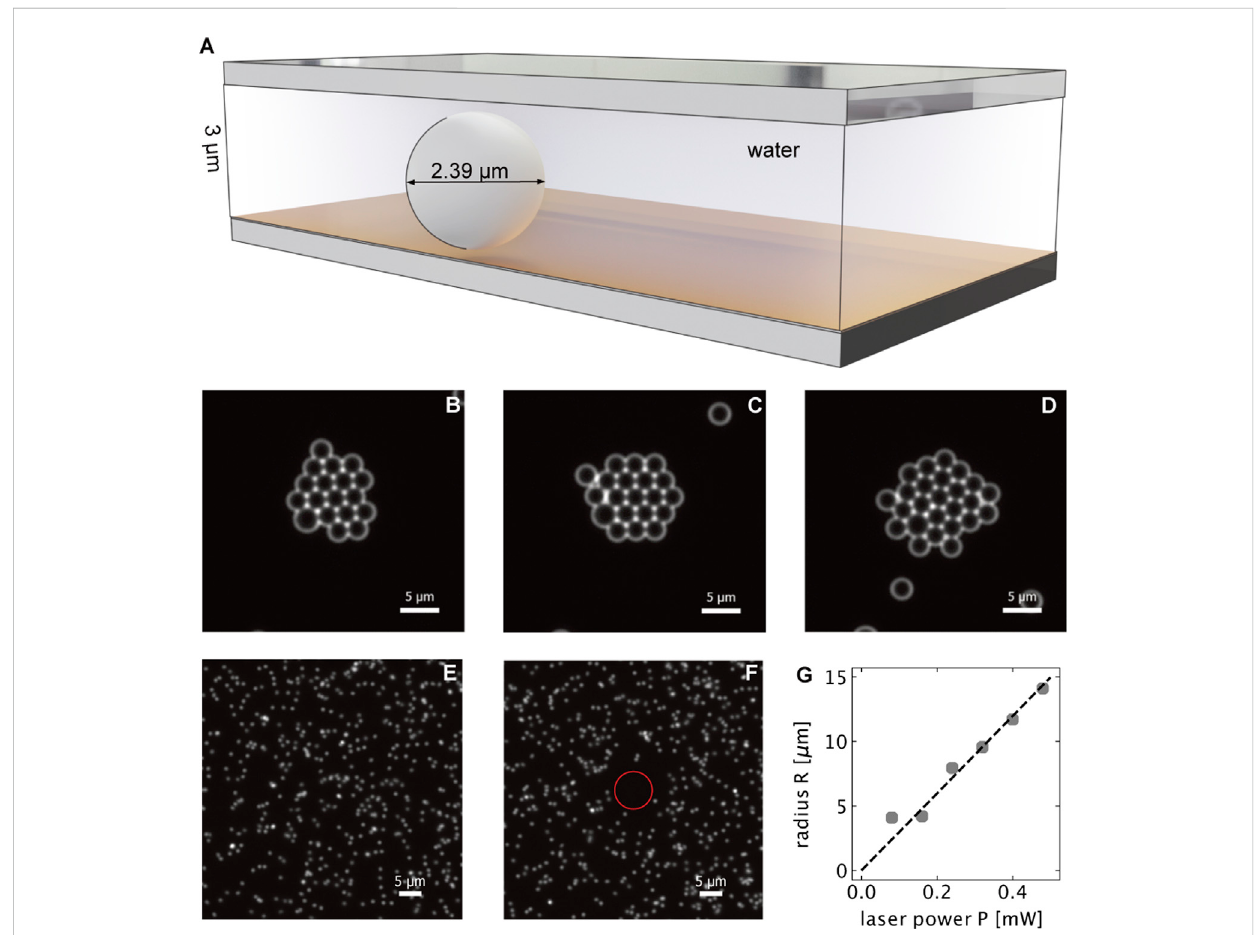
FIGURE 2 (A) Geometryofthesampleusedforcolloidalcrystalassemblyof2.39 μ mPSparticlesduetothermo-osmotic fl ows. (B – D) Colloidalcrystal formed (at p = 0.6 mW) after 15, 30 and 60 min, respectively. (E, F) demonstrate the thermophoretic repulsion of 518 nm diameter PS beads in a 3 μ m thin water fi lmabovean 30 nmthingold fi lmwithout (E) andwith (F) localized optical heating.The circle enclosestheregionofno particles. (G) shows theradiusof the cirlce enclosing this region of depleted PS particles as a function of the laser